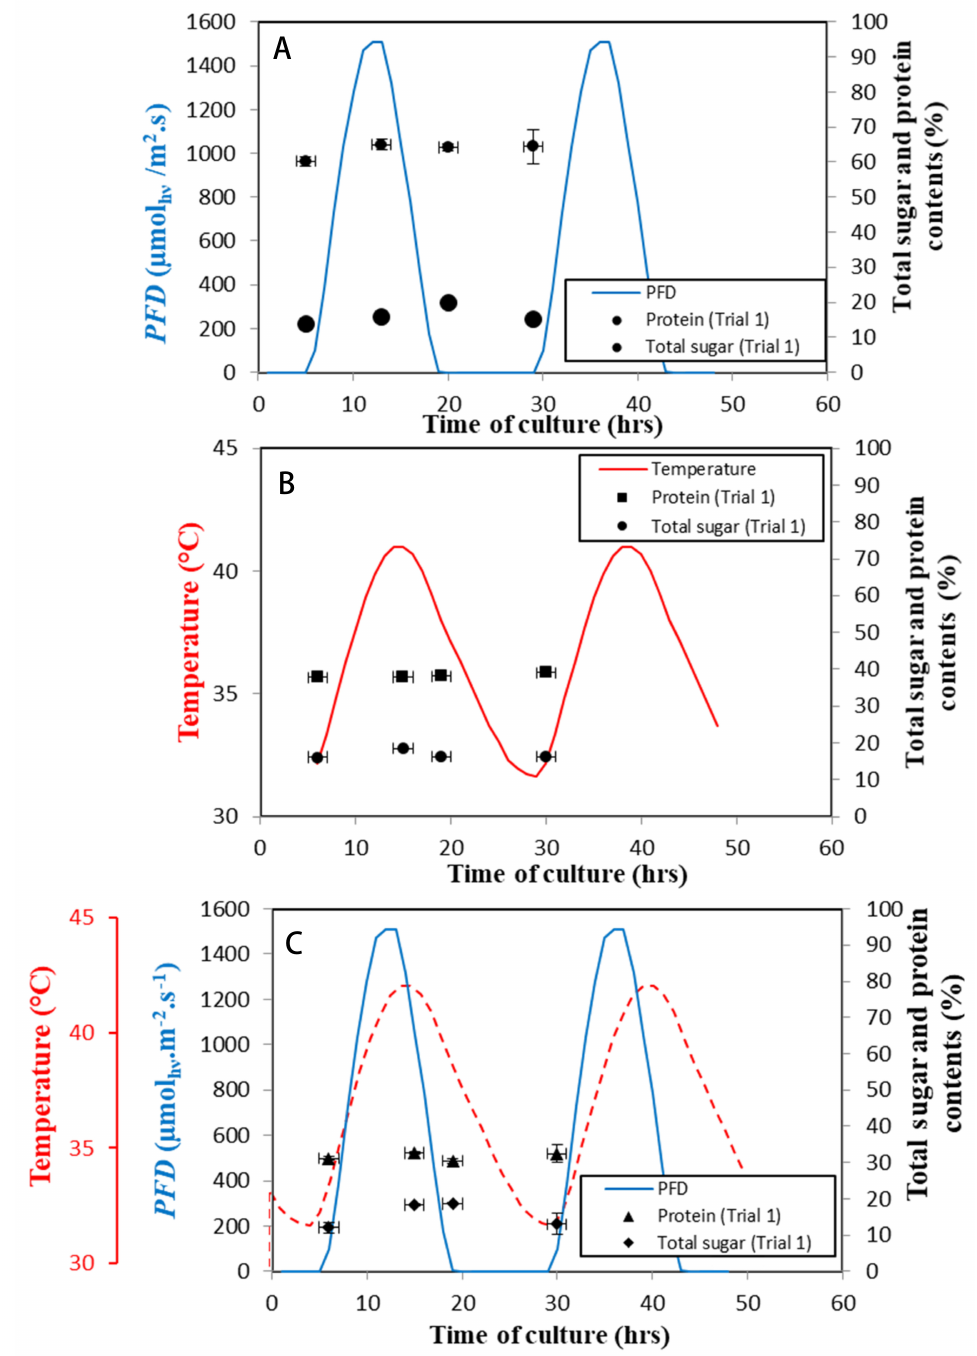
Figure 9. Total sugar and protein contents of N . sp QU130 evolutions over 24 h under three different cultivation regimes: ( A ): Cultivation under day/night cycles; ( B ): Cultivation under temperature fluctuation and ( C ): Cultivation under combined light and temperature cultivation. Results are given for trial 1 (similar results for other